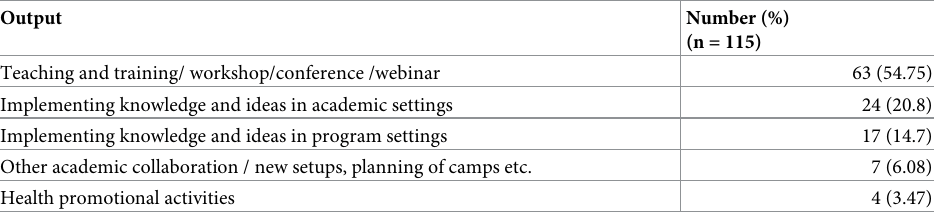
Table 6. Output of IPHMDP received through Action plan submitted by